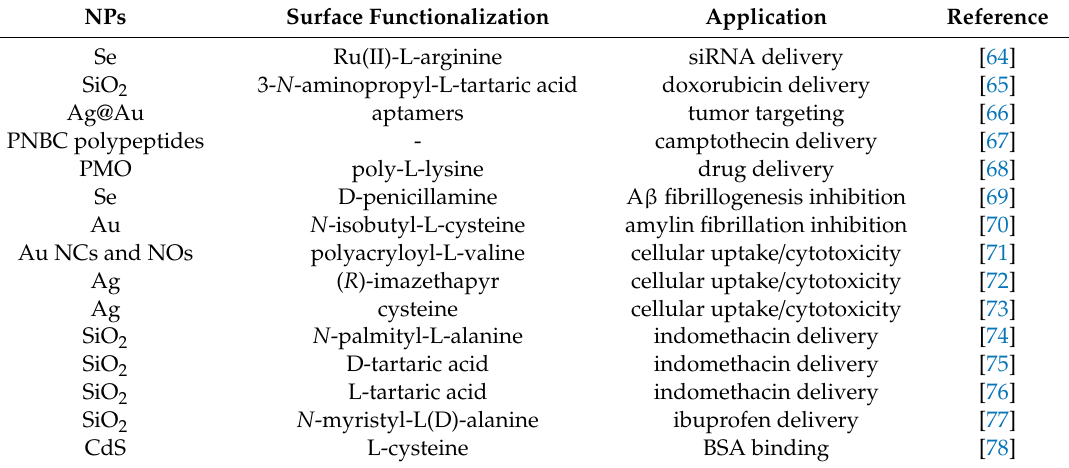
Table 3. Main applications of chiral NPs for biomedicine and their principal characteristics.